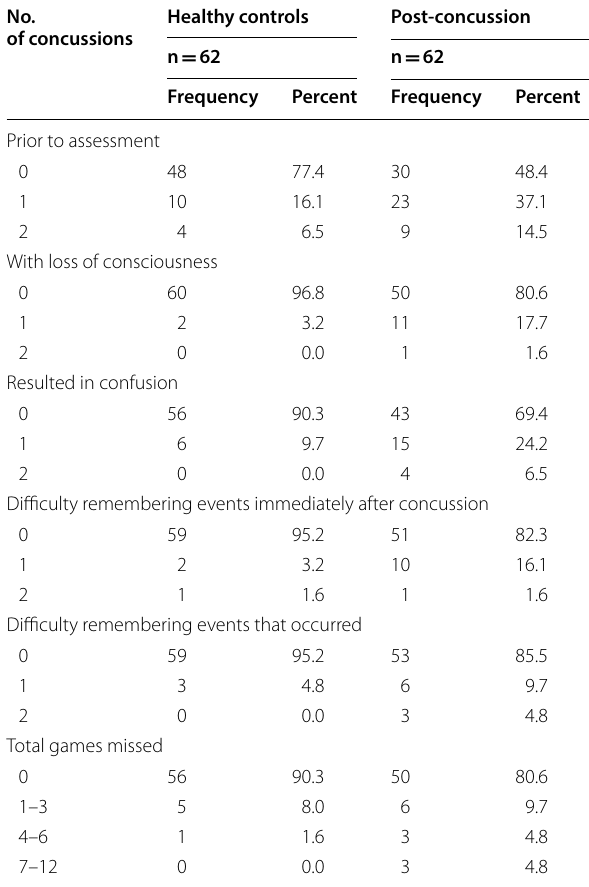
Table 5 Immediate post-concussion assessment and cognitive test (ImPACT) composite scores N